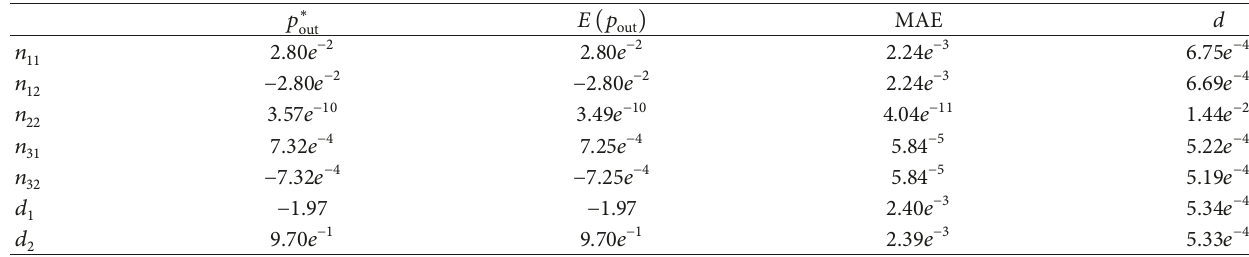
Figure 5: Histograms, SS to ARX transformation. Table 2: SS to TF transformation